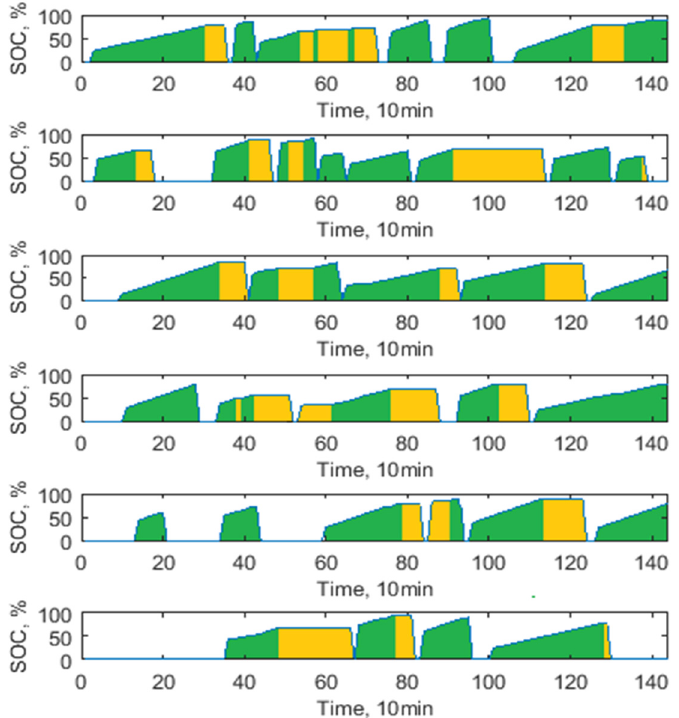
Figure 16. Changes in the SOC of freight EVs at six charging points during charging according to the proposed situational algorithm with CWI (Green—EV is charging; yellow—EV is on hold).